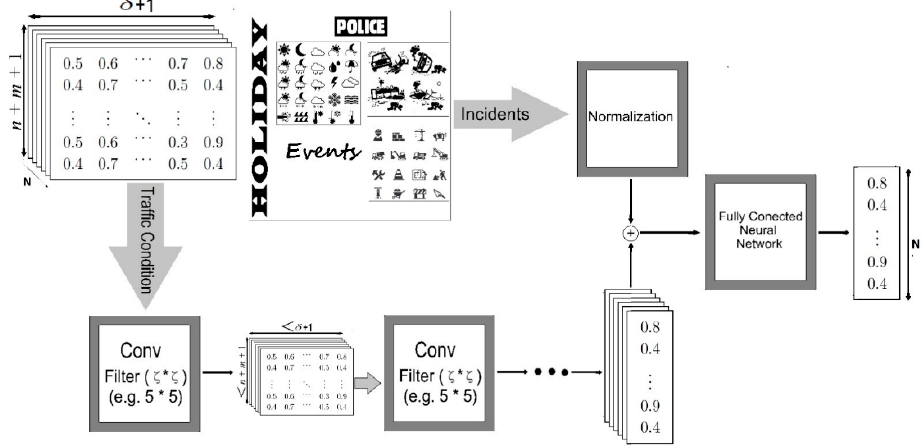
Figure 1. Overall processing structure of the road congestion prediction model.